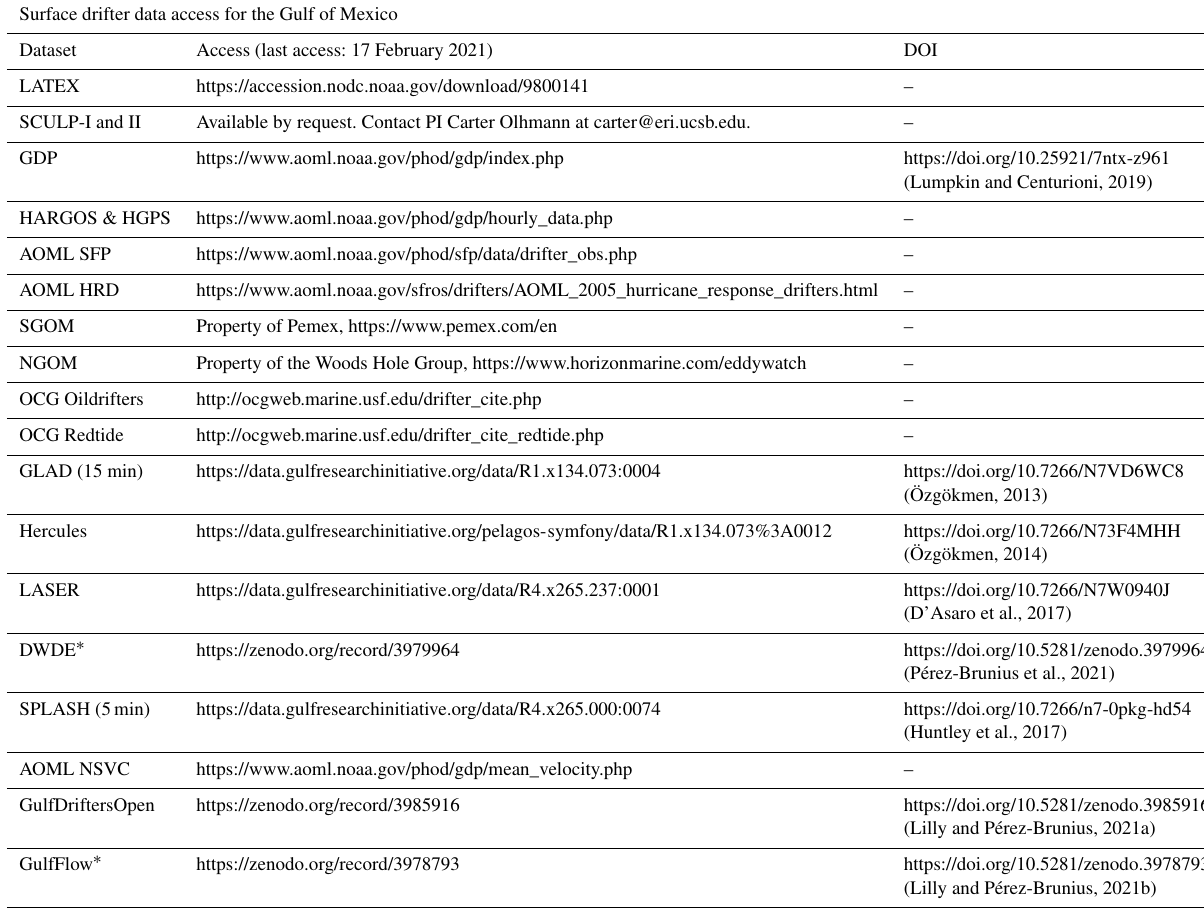
Table 3. Availability of the various drifter datasets used in this paper, together with the two datasets created herein. Surface drifter data access for the Gulf of Mexico